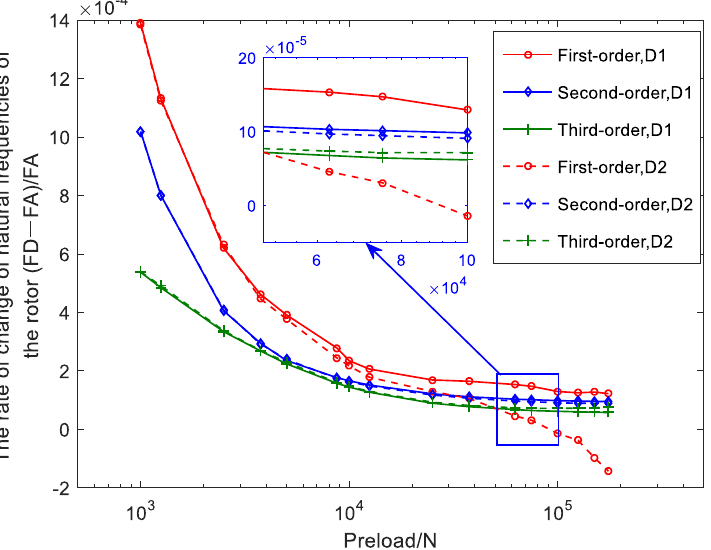
Figure 15. The rate of change of natural frequencies of the RFR considering the parallel relationship between the tie rods and rotor.